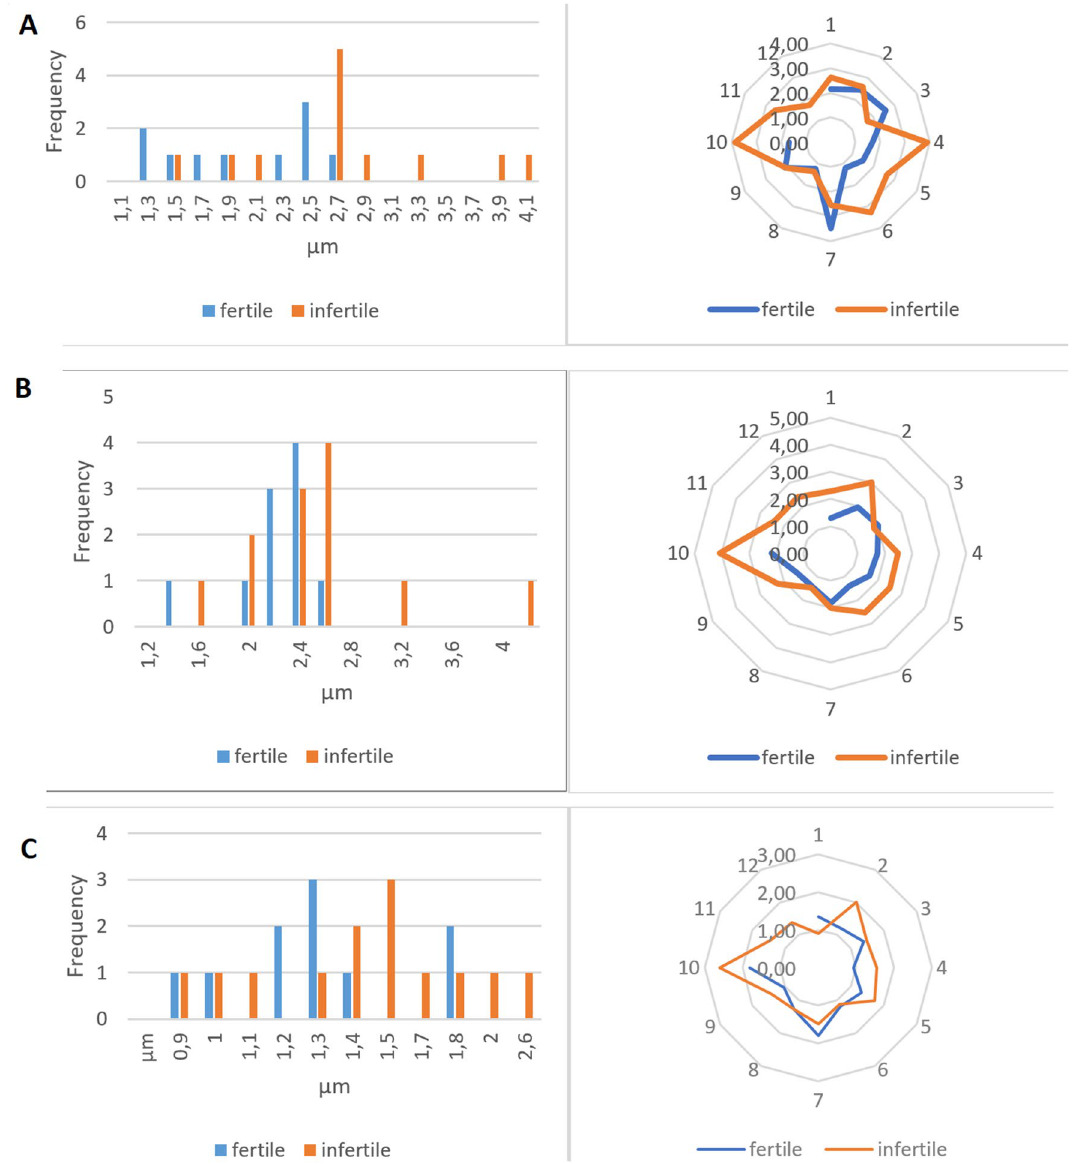
Figure 2. Data range of novel spermatozoa parameters measured by DHM for fertile and infertile men. ( A ) Range of values for hh in fertile men (median-1.90 µm) narrowed down in a statistically significant manner compared to the infertile group (median-2.61 µm) ( P < 0.05). ( B ) Range of values for amh (acrosome/nucleus height) narrowed down in a statistically significant manner for the group of fertile men (median- 1.69 µm) vs. infertile individuals (median- 2.34 µm) ( P < 0.002) ( C ) The median of hmh for fertile men was 1.30 µm while that for infertile individuals was – 1.47